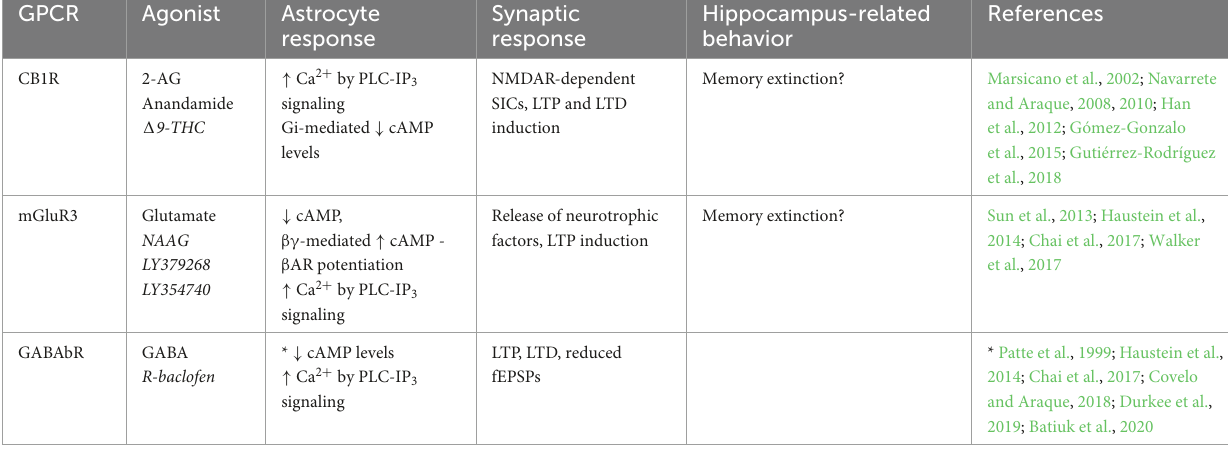
TABLE 3 Endogenous Gi-GPCRs in adult mouse hippocampus: Synaptic and behavioral